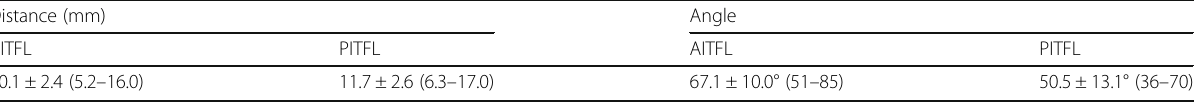
Table 2 Mean distances and angles between the center points of the tibial and fibular insertion sites of the AITFL and PITFL Distance (mm)